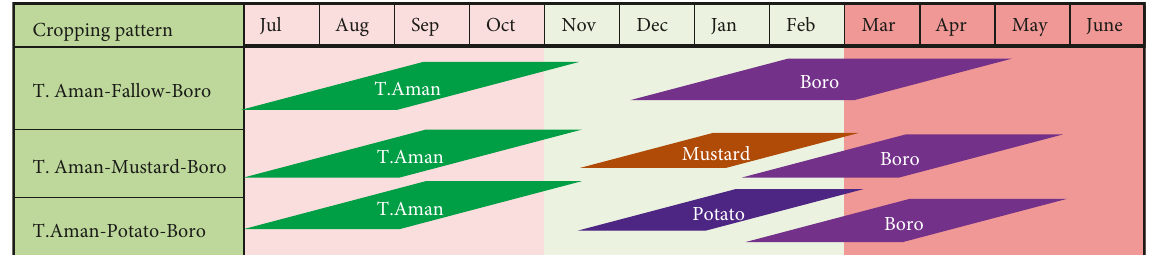
Figure 1: Overview of crop planning in different cropping patterns at Mithapukur and Pirganj,